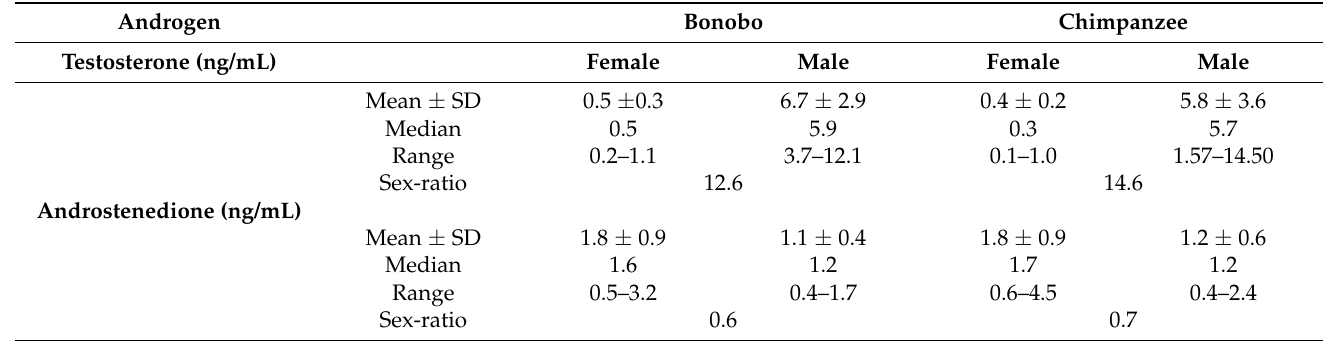
Table 2. Mean, median, and ranges of female and male bonobo and chimpanzee androgens. Sex ratios of mean testosterone and androstenedione in bonobos and chimpanzees are calculated. Androgen Bonobo Chimpanzee Testosterone